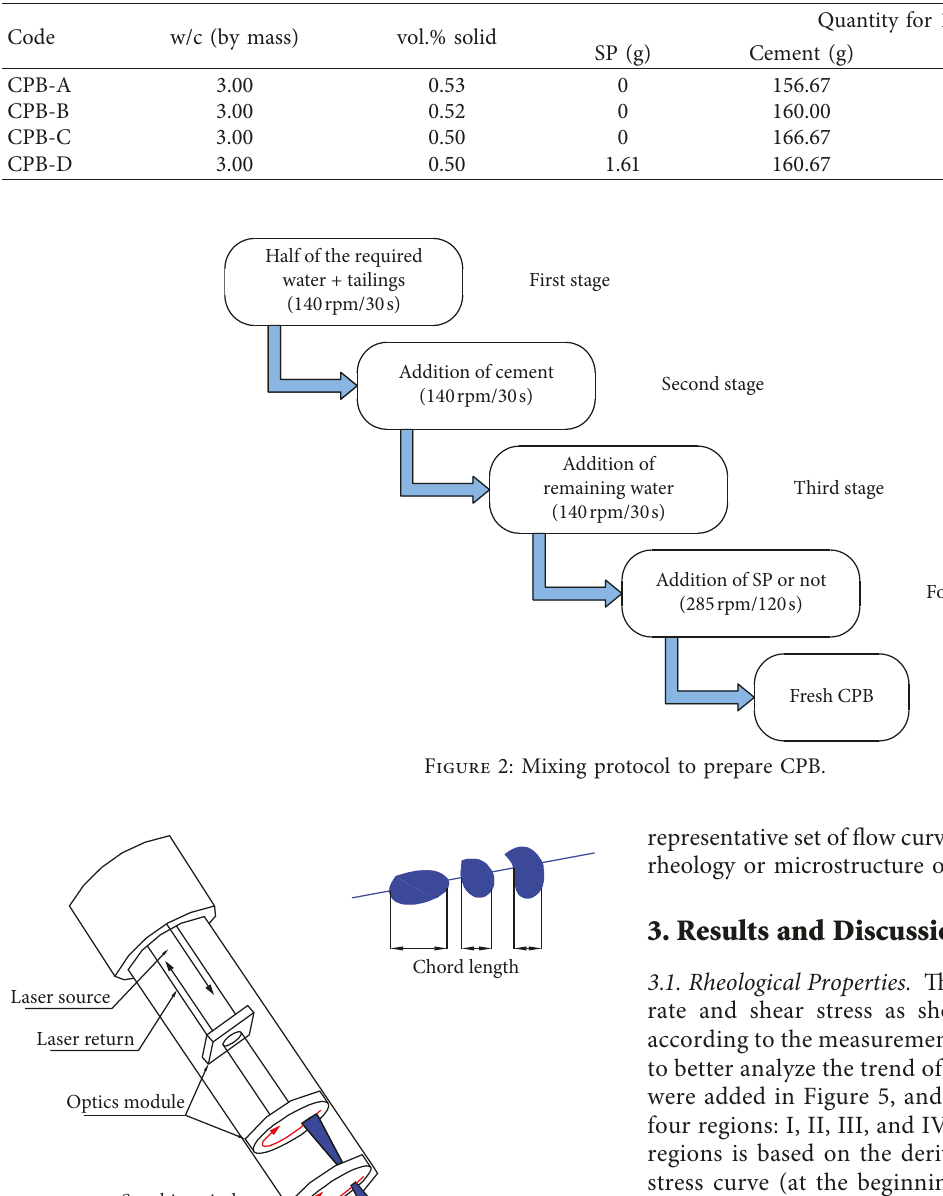
Table 3: Mixture proportions of CPB.